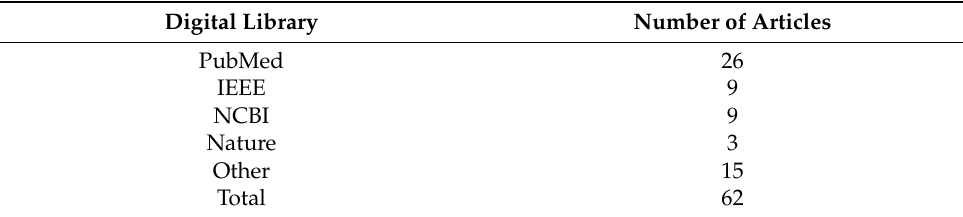
Table 1. Selected papers for this study from different libraries.